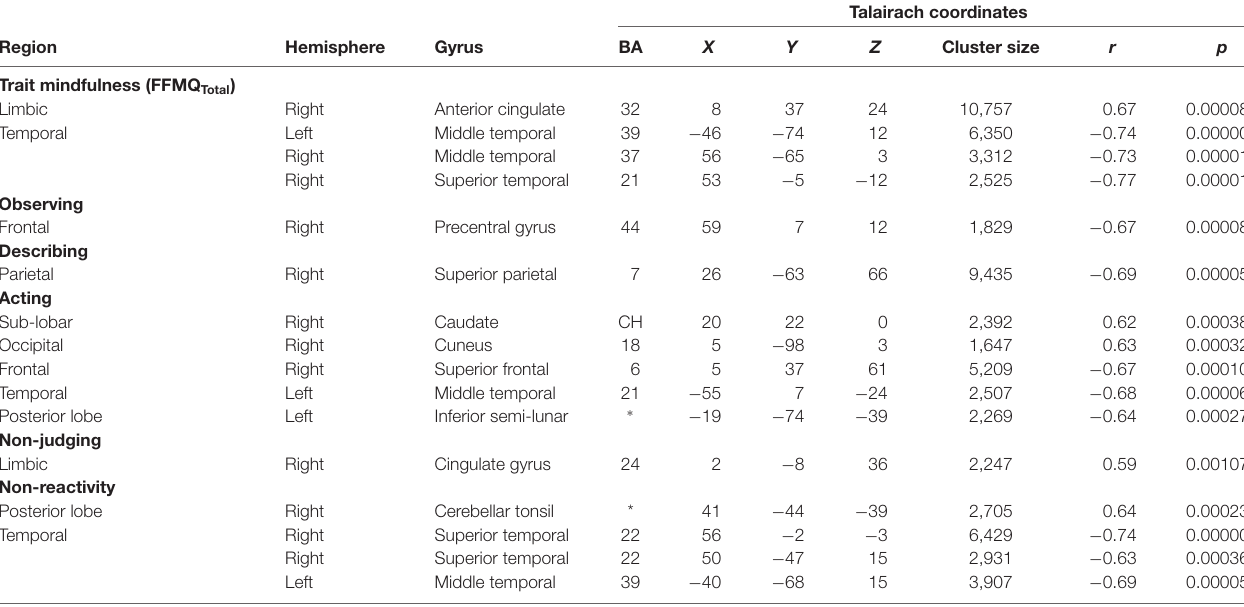
Talairach coordinates